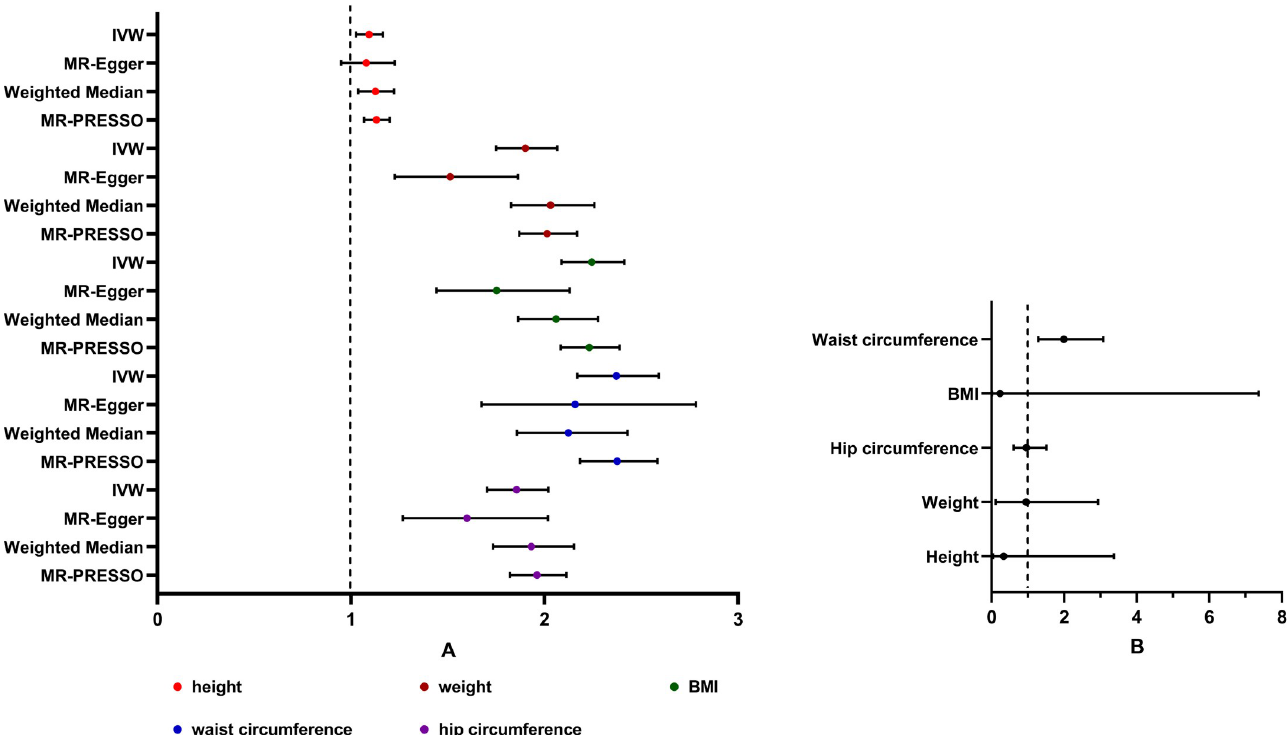
Fig 3. Forest plot for univariable and multivariable MR analyses of the causal effect of anthropometric measurements on knee osteoarthritis. A. Estimated causal effects of anthropometric measurements on knee osteoarthritis using univariable MR. The genetically predicted height, weight, BMI, waist circumference, and hip circumference are included. Inverse-variance weighted (IVW), MR-Egger, weighted median and MR-PRESSO represent different Mendelian randomization models. B. Estimated causal effects of anthropometric measurements on knee osteoarthritis using multivariable MR. MVMR results are from adjusting all 5 measurements together for knee OA